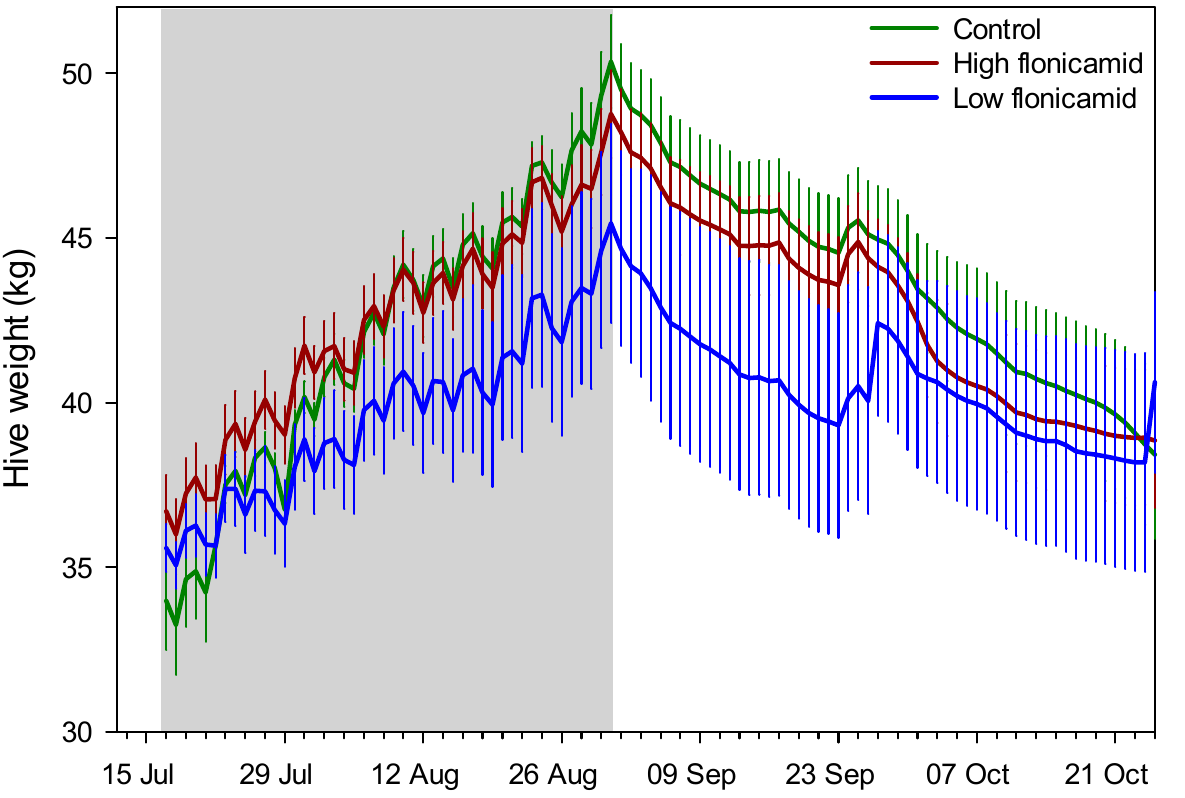
Figure 2. Daily mean (SE) hive weight for the three treatment groups, “High flonicamid” (250 ppb); “Low flonicamid” (50 ppb) and “Control” (0 ppb). The gray zone indicates the treatment application period. Shown are data until the end of October, which typically marks the end of the active foraging season in southern Arizona.